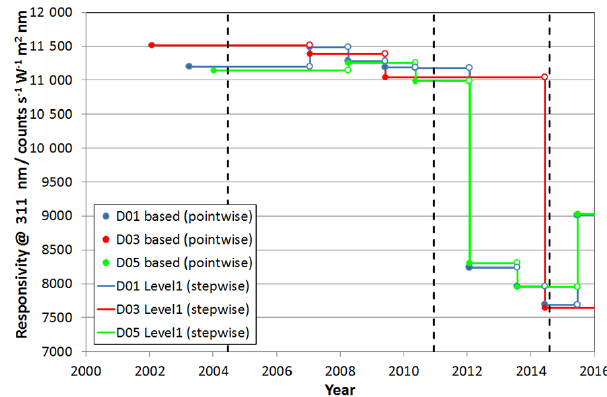
Figure 7. Responsivity of Brewer #107 as determined on the basis of the newly recalibrated primary standard lamps D01, D03, and D05 (discrete values) and the corresponding stepwise constant re- sponsivity of type Level1 used for near real-time processing of solar UV irradiance